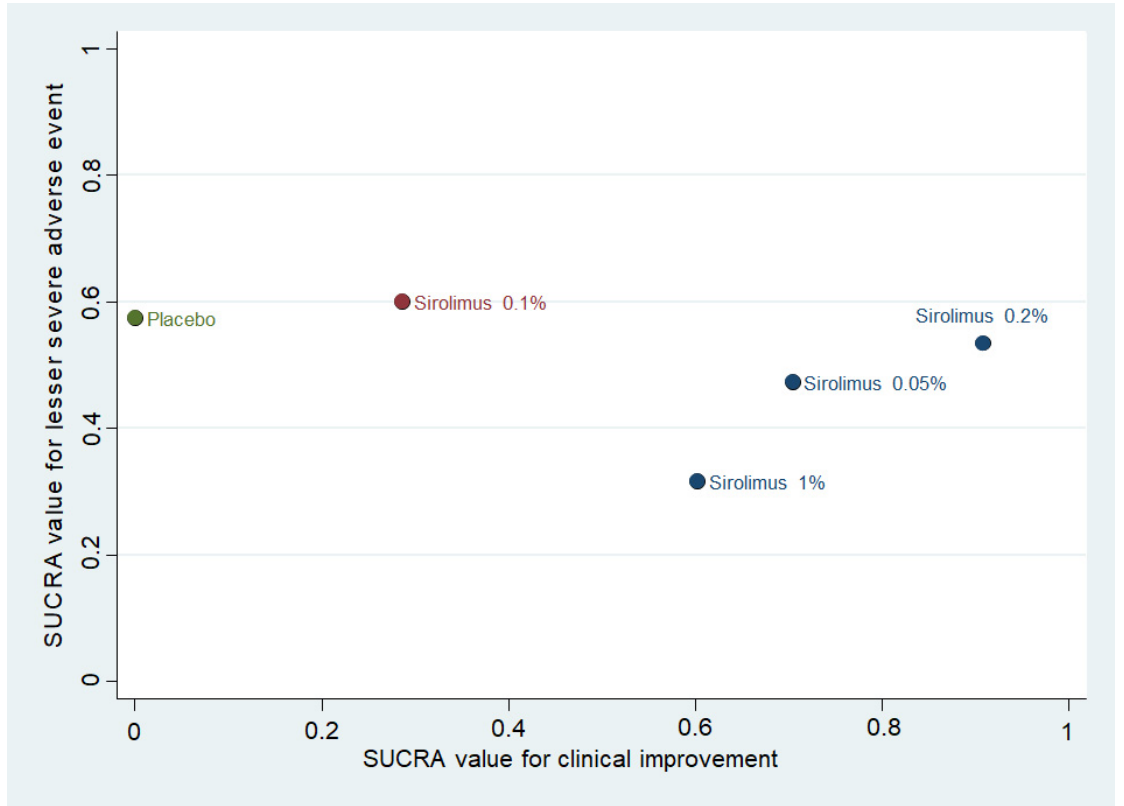
Figure 4. Ranking plot of different treatments for facial angiofibroma based on the surface under the cumulative ranking curve (SUCRA) values for two outcomes: clinical improvement and severe adverse events leading to withdrawal. Treatments in the upper right corner were associated with greater increase in complete clearance and lesser adverse events associated withdrawal than the other treatments.